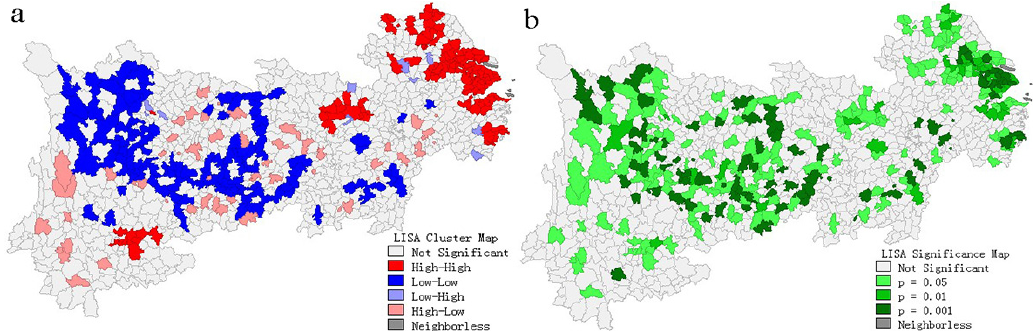
Figure 8. Urban space agglomeration map and saliency map of the YREB in 1992. ( a ) LISA cluster map of the YREB in 1992, ( b ) LISA significance map of the YREB in 1992.